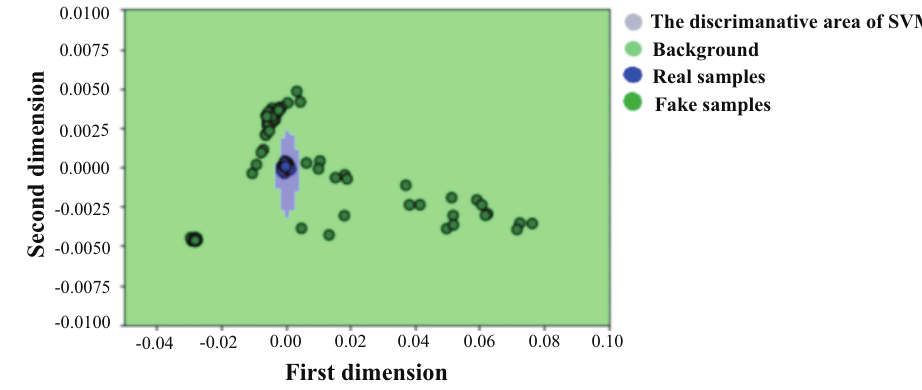
Figure 8. Discriminating space by the improved GAN.